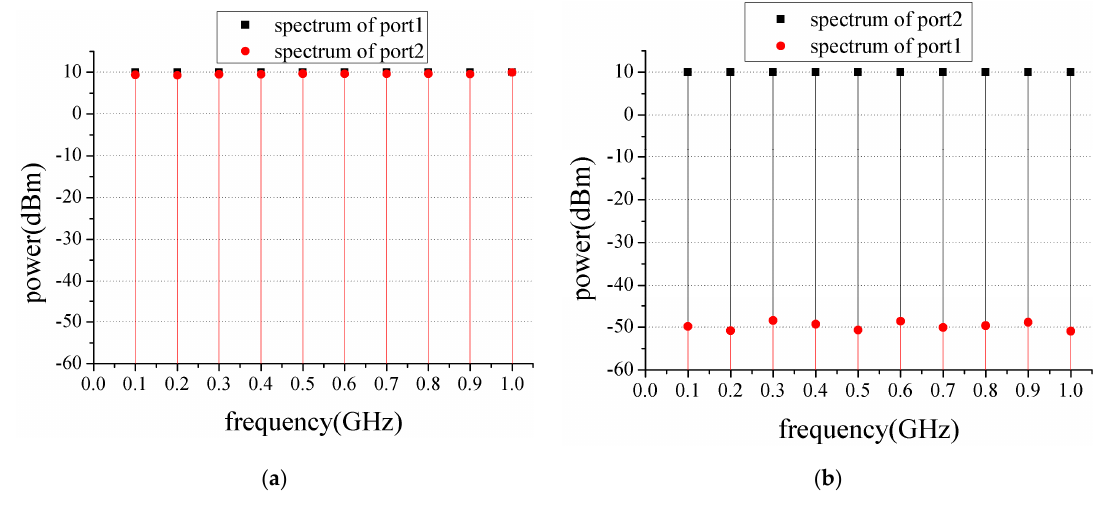
Figure 2. Spectrum analyzing results of the STI. ( a ) Input from port 1; and ( b ) input from port 2.